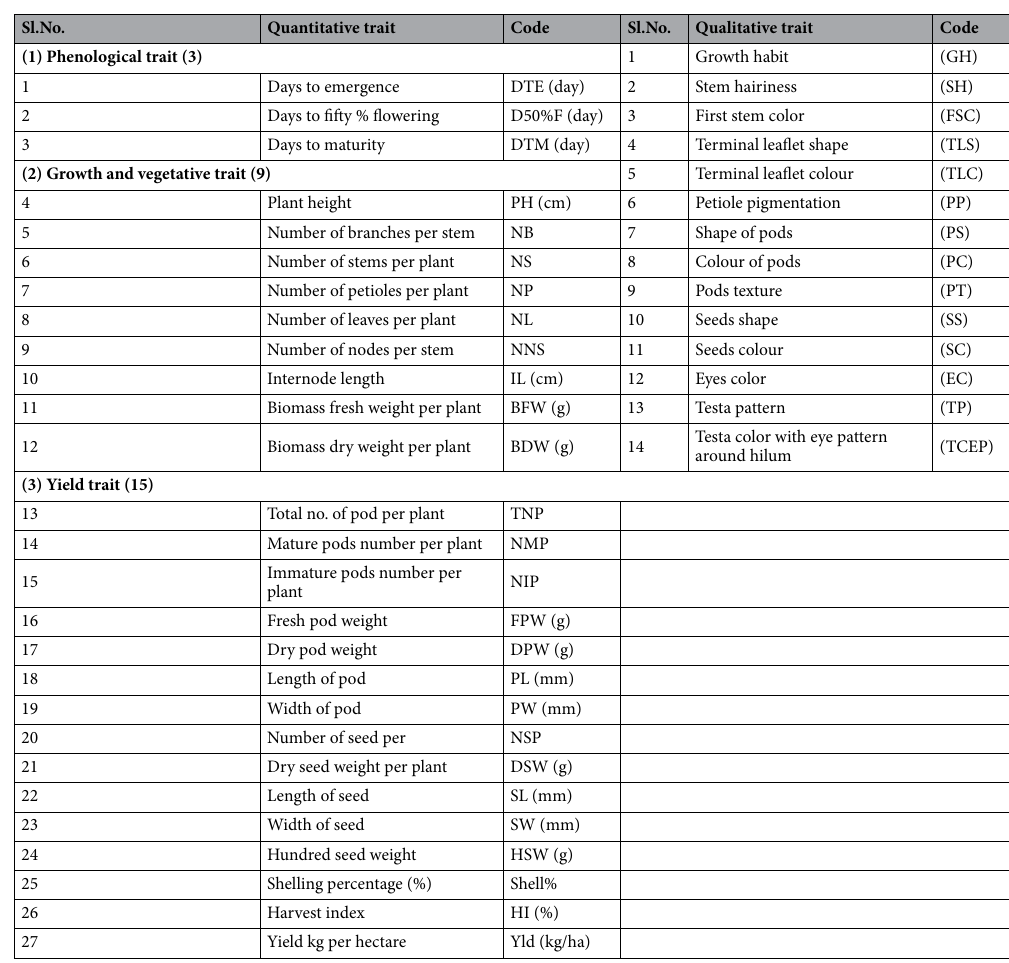
Table 2. Twenty-seven quantitative and 14 qualitative traits measured according to IPGRI, IITA, BAMNET 32